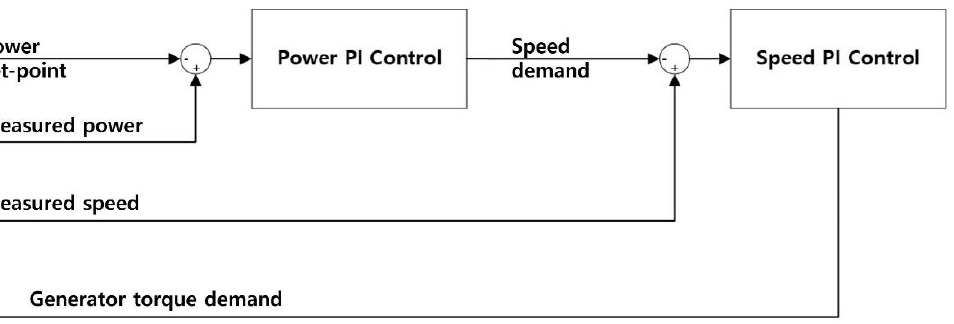
Figure 13. Block diagram of the power controller of the VSFP wind turbine proposed in a previous study.